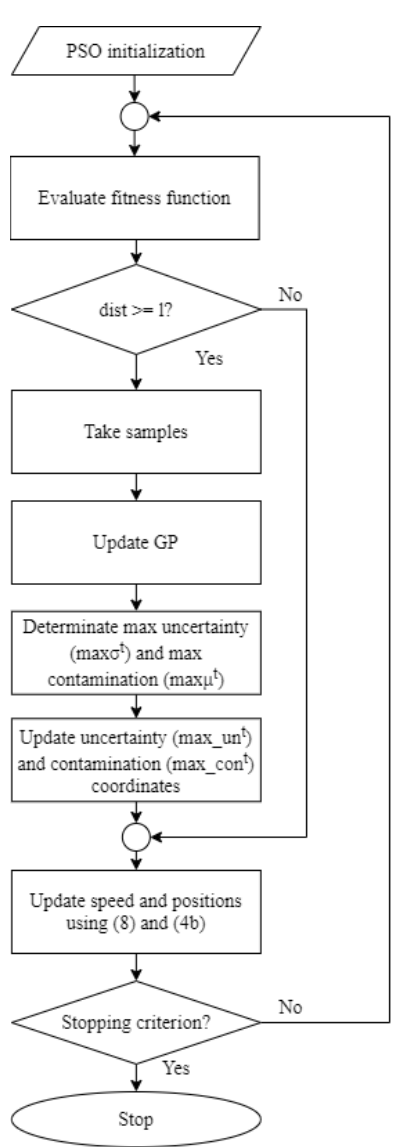
Figure 3. Flowchart of the proposed